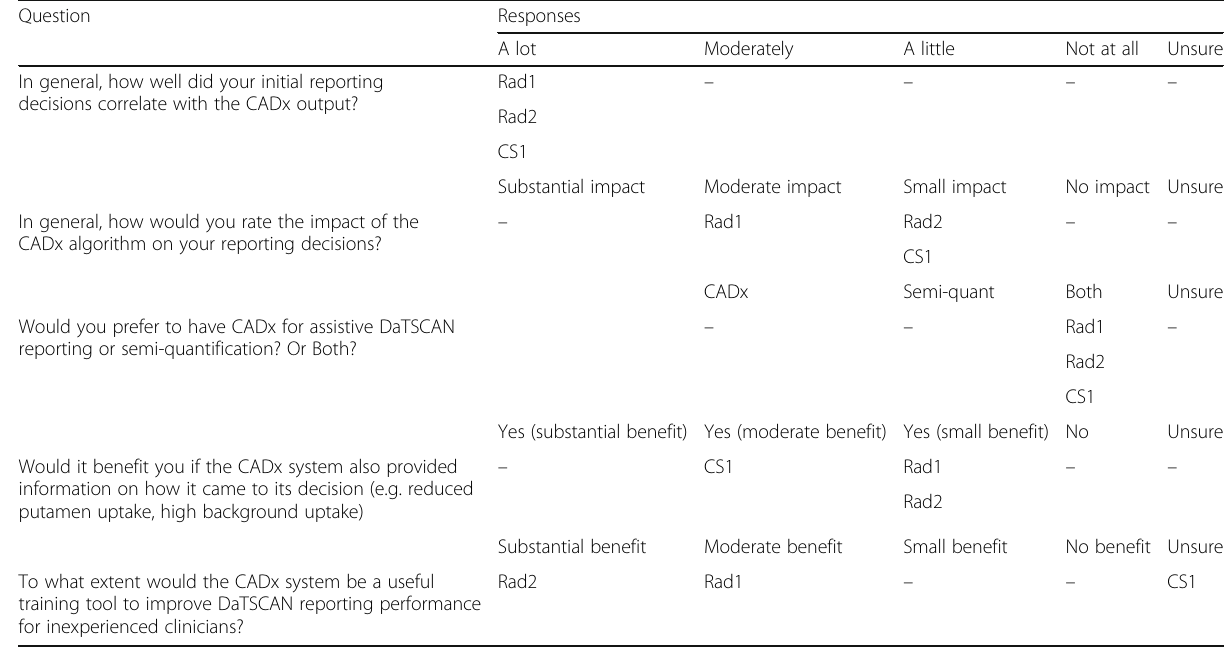
Table 3 Summary of responses to the questionnaire (restricted response categories only)